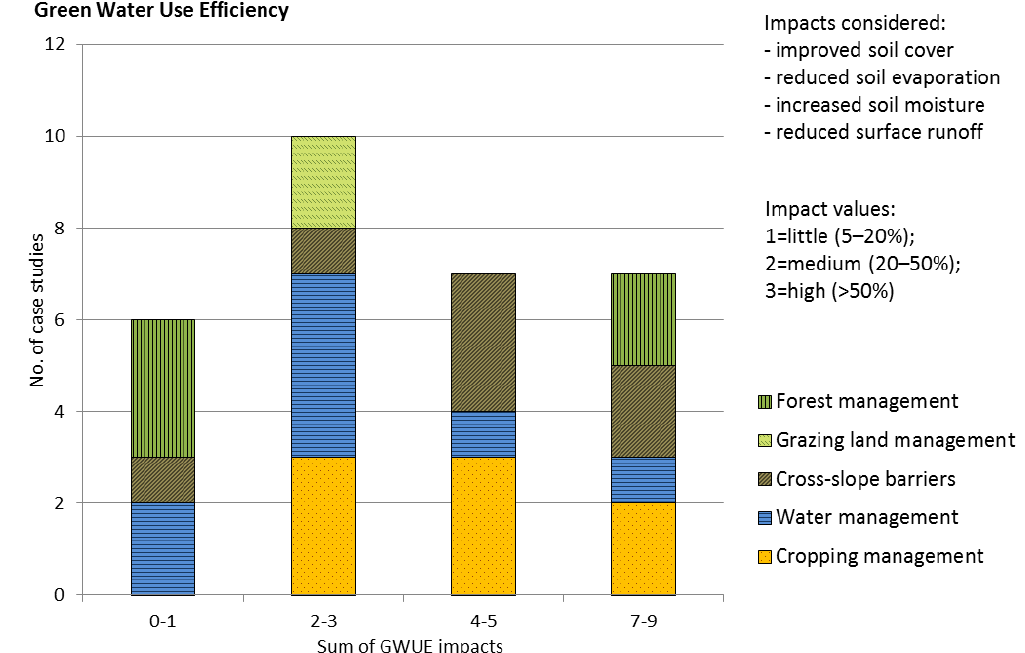
Figure 4. Aggregated impacts of SLM practices in regards to Green Water Use Efficiency (source: Schwilch et al., 2014).